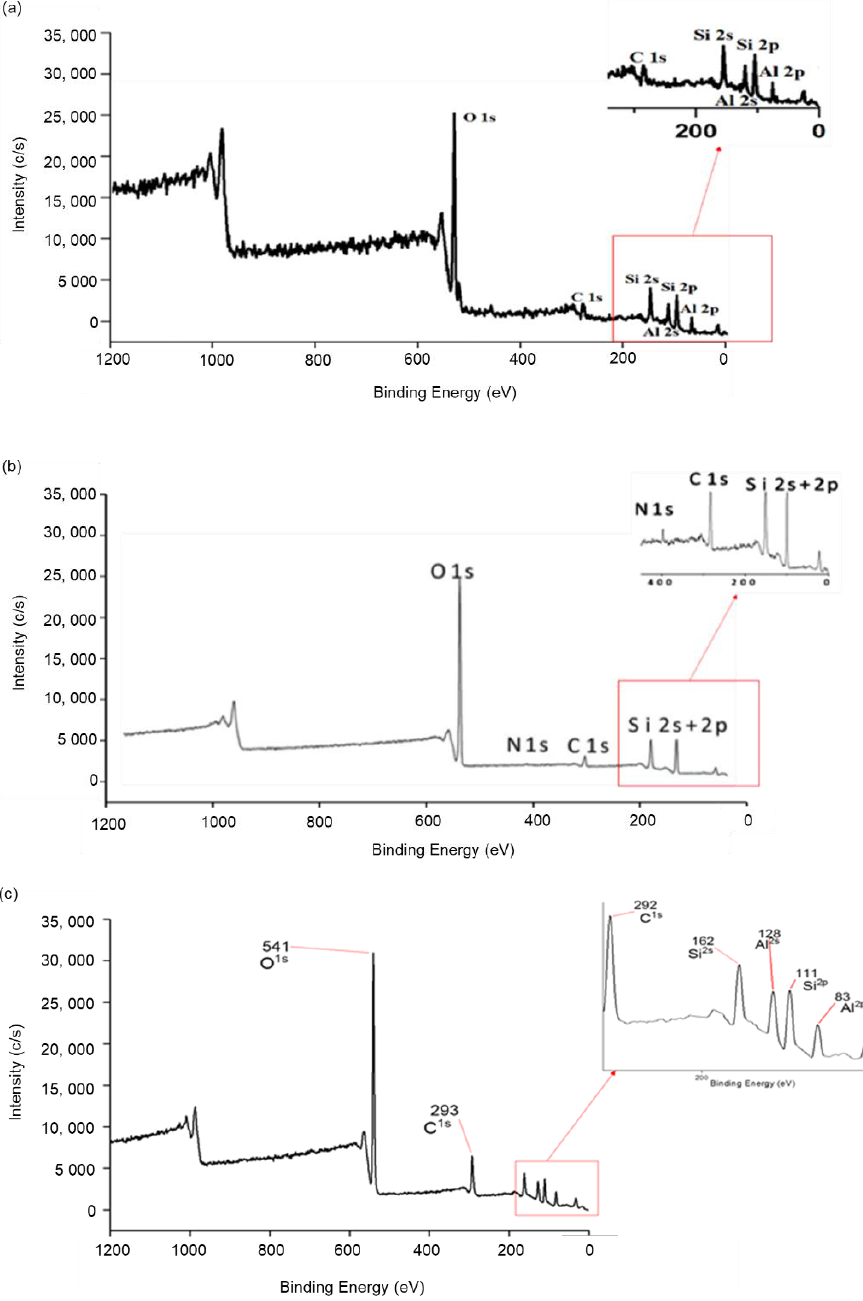
Figure 5. XPS scan of ( a ) HNT., ( b ) CTS-Si, and ( c ) CTS-Si/HNT. Table 3. Surface atomic percentages determined by XPS of CTS-Si/HNT., HNT., and CTS-Si.